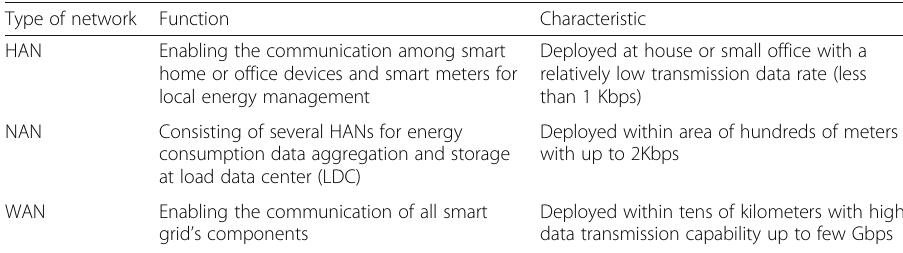
Table 3 Summary of communication infrastructure in smart grid Type of network Function Characteristic